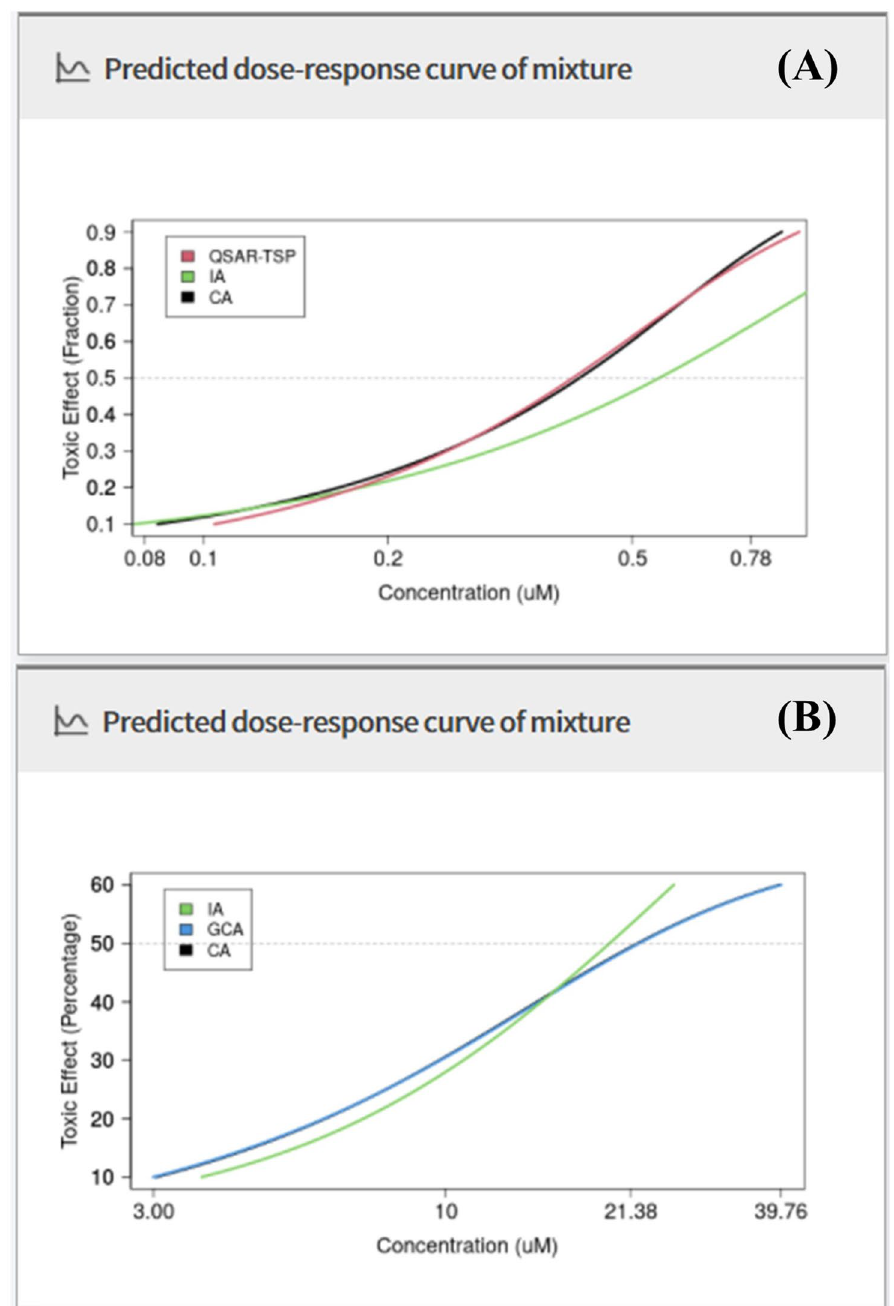
Figure 6. Comparisons of CA, IA, GCA, and QSAR-TSP predictions. ( A ) Case Study 1; and ( B ) Case Study